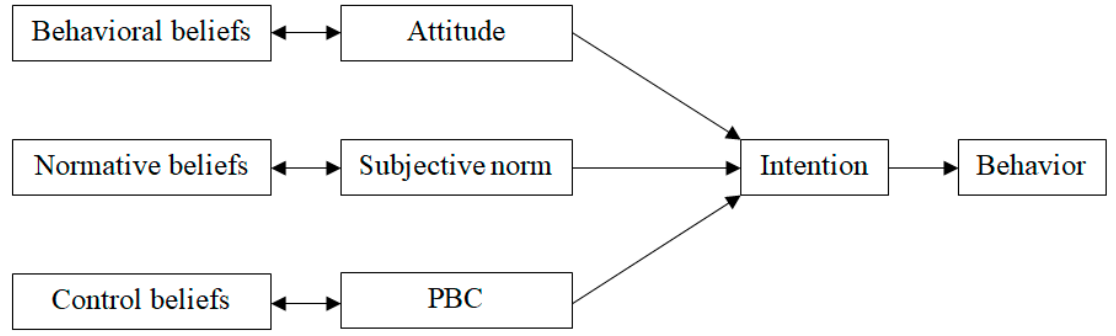
Figure 1. The theory of planned behavior [14].